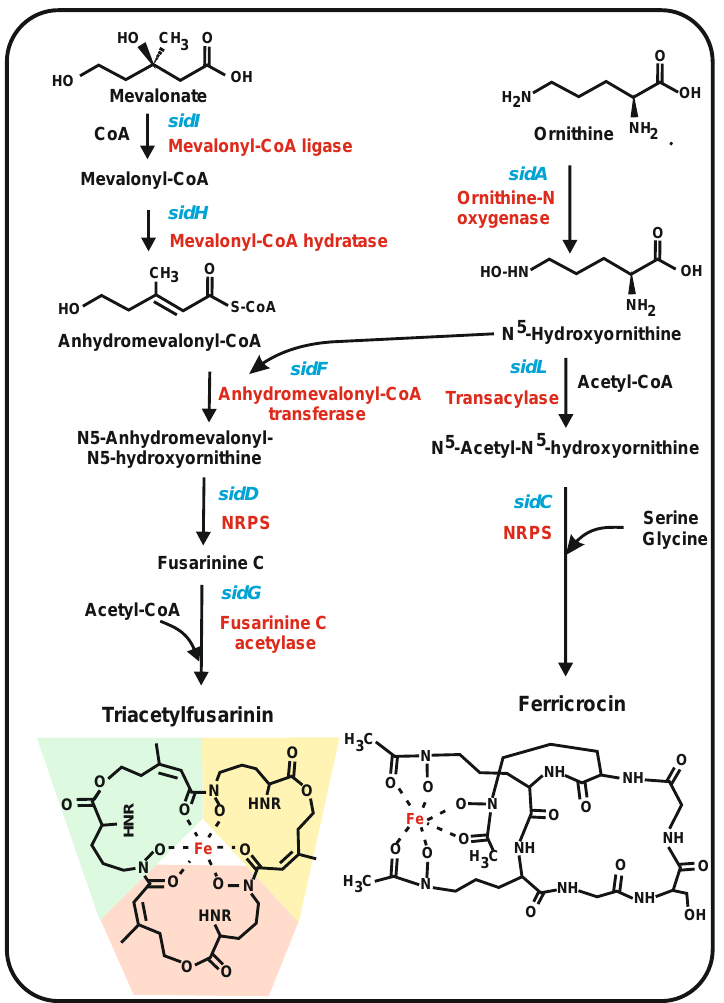
Figure 6. Biosynthesis of the siderophores triacetylfusarinine and ferricrocin. Both biosynthetic pathway and their interaction are shown. The enzymes are labeled in red letters; the genes are indicated in blue letters. At the bottom of the figure are shown the structures of triacetylfusarinine and ferricrocin and the position of the chelated iron atom forming hydroxamates. The three molecules of acetylated N 5 -anhydromevalonyl-N 5 -hydroxyornithine that form the TAFS structure are shadowed in yellow, green, and pink, respectively.